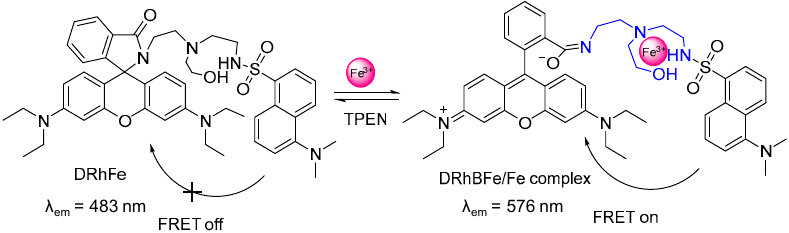
Figure 7. The reversible response mechanism of DRhFe to Fe 3+ [48].